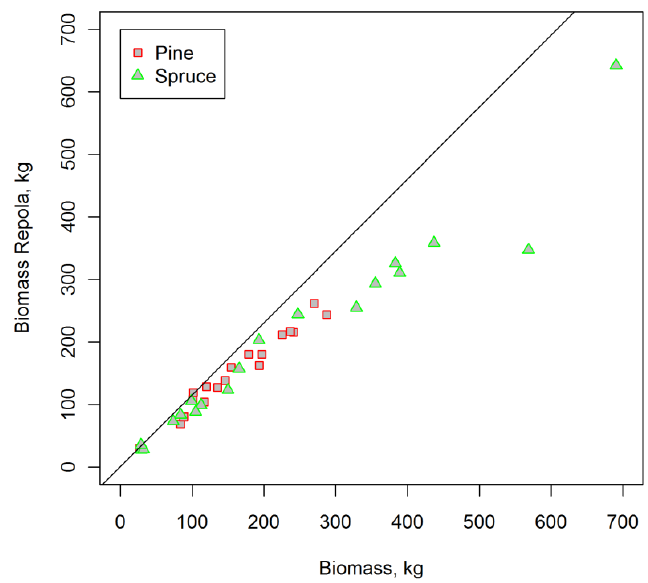
Figure 3. Total biomass of tree (kg) predicted with biomass models [42] vs. laboratory-derived biomasses, red = Scots pine and green = Norway spruce.